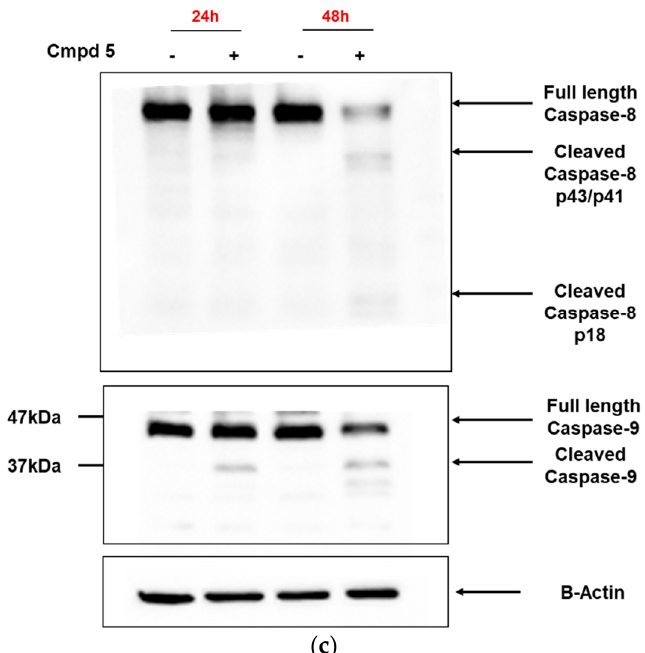
Figure 3. Activation of caspase 8 and caspase 9 in leukemia cells treated with compounds 3 , 5 and 6 . K562 ( a ) or MOLT-4 cells ( b ) were treated with 3 , 6 or staurosporine (ST) for 6 or 3 hours, respectively. Activity of caspases in cells exposed to 1% DMSO was normalized to 1.0. Means +/ − SD are shown. ( c ) Western blot analysis of cleavage of caspase 8 and caspase 9 in K562 cells incubated with 5 (5 µ